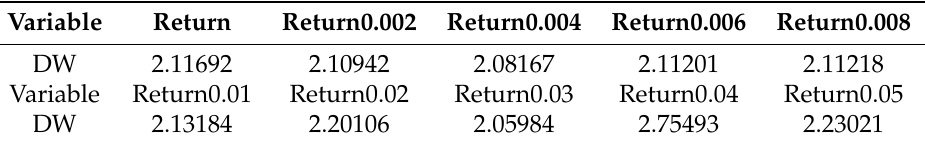
Table 2. Durbin–Watson test.